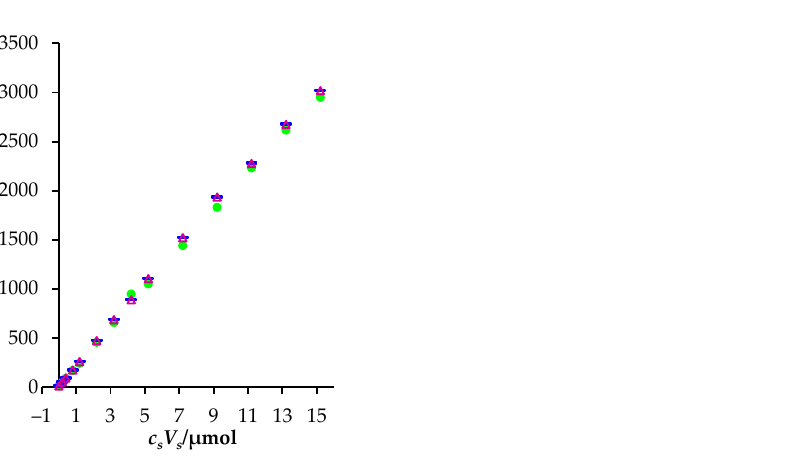
Figure 5. Gran plots obtained measuring TBZ concentration in aqueous sample of known concen- tration ( c = 1.0 × 10 − 5 M, three repeated measurements).